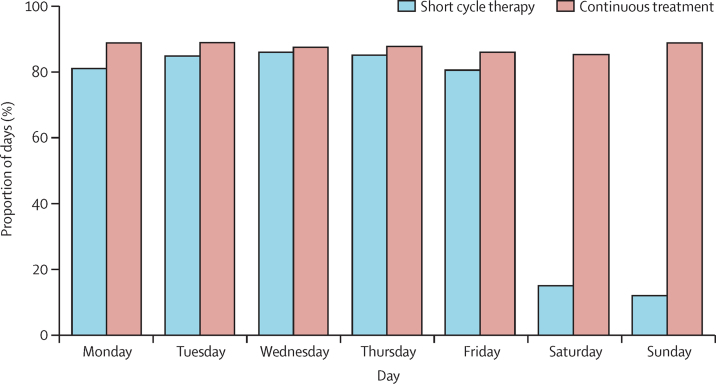
Proportion of days MEMS caps were openedData for 31 participants in the short cycle therapy group and 30 participants in the continuous treatment group (including 23 in each group with data to 48 weeks). MEMS=Medication Event Monitoring System.